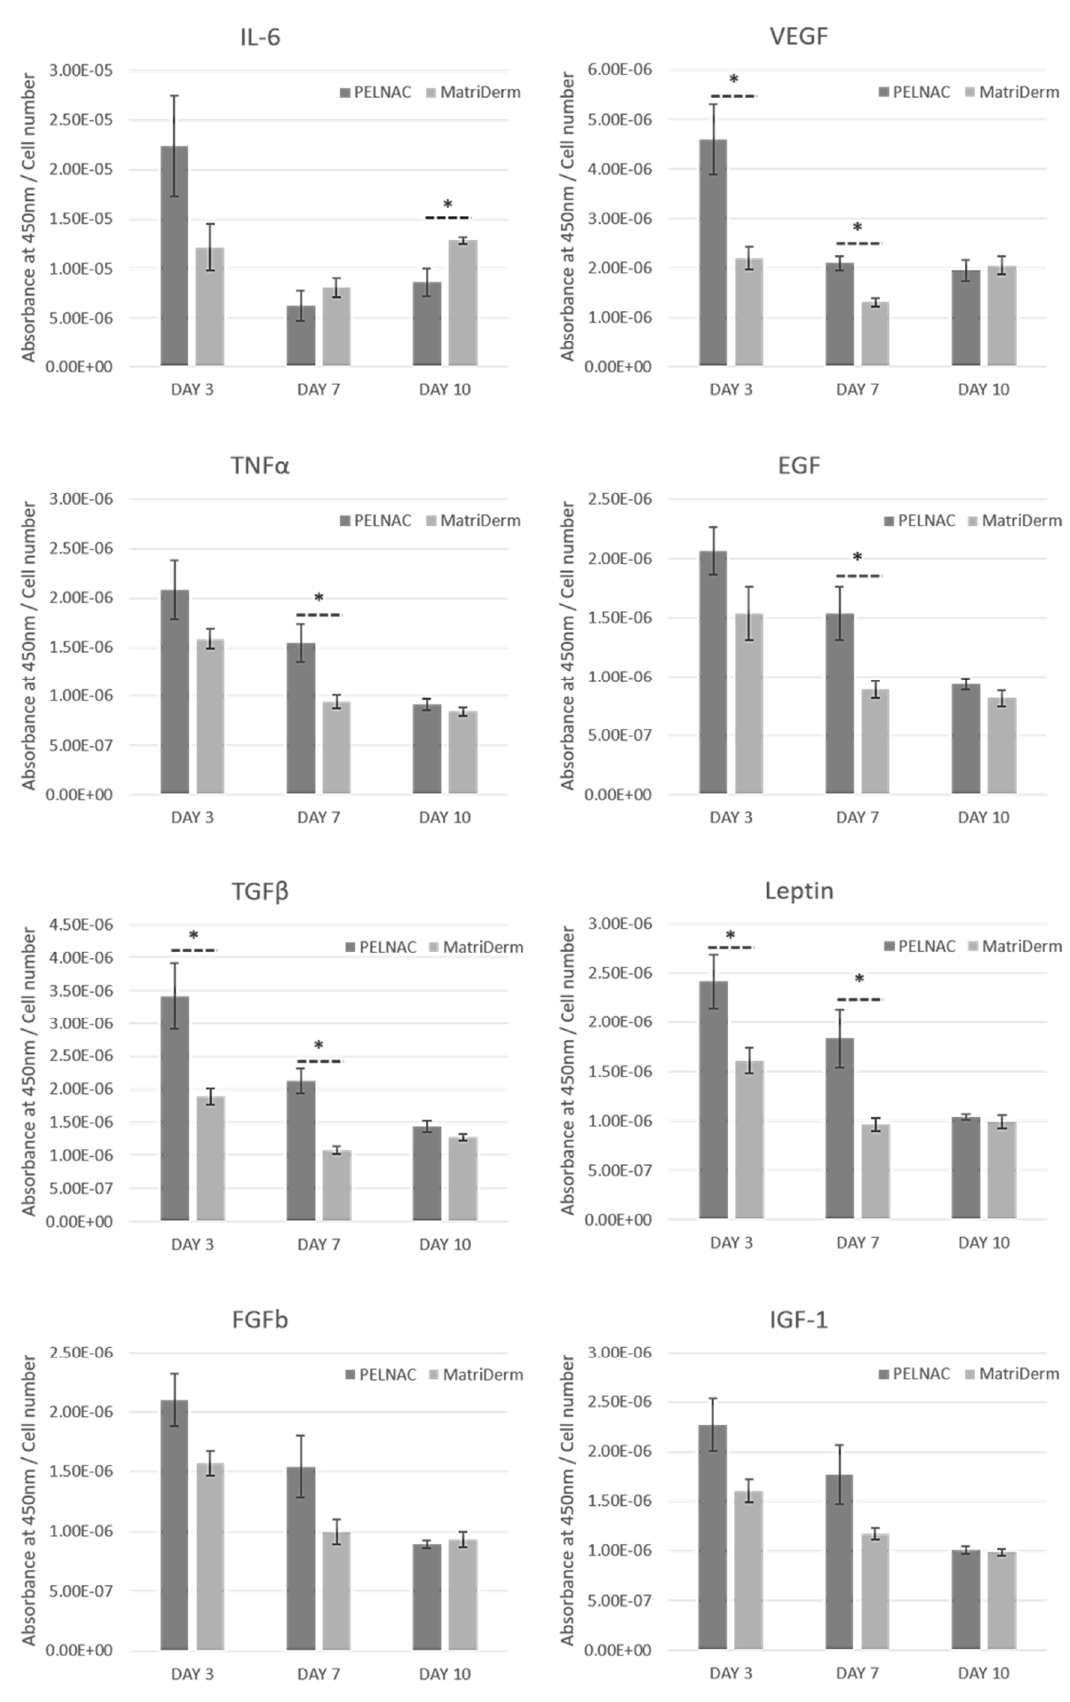
Figure 9. Secretion of exogenous cytokines and growth factors. Results show average ± standard error of mean ( n = 4). * p < 0.05.